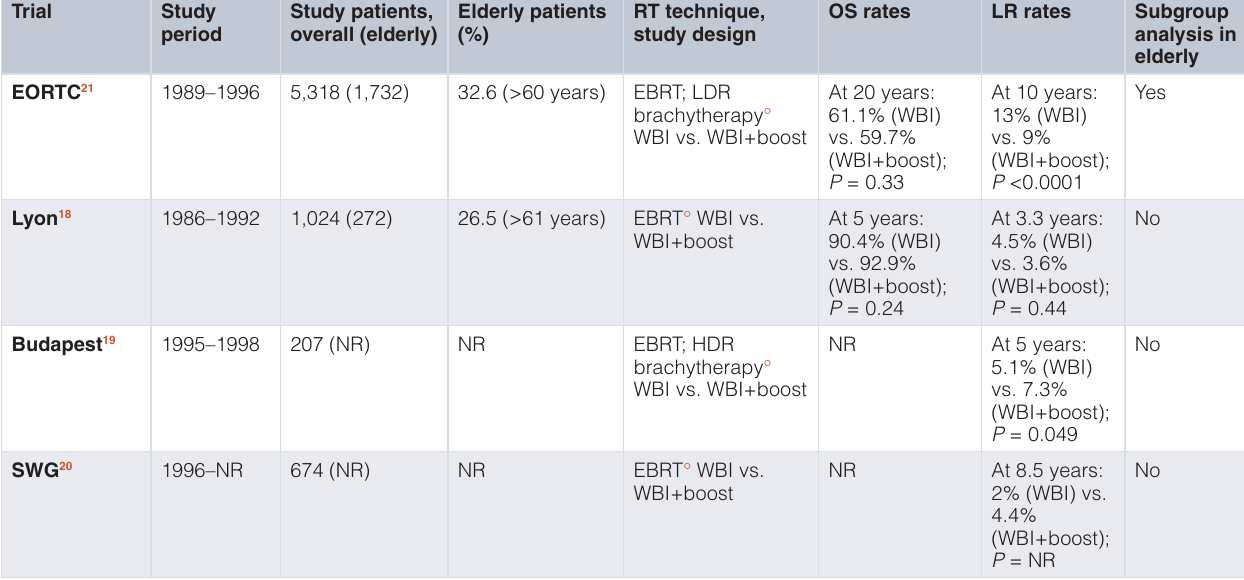
Table 1. Phase III trials investigating tumor bed boost after breast-conserving surgery. Trial Study